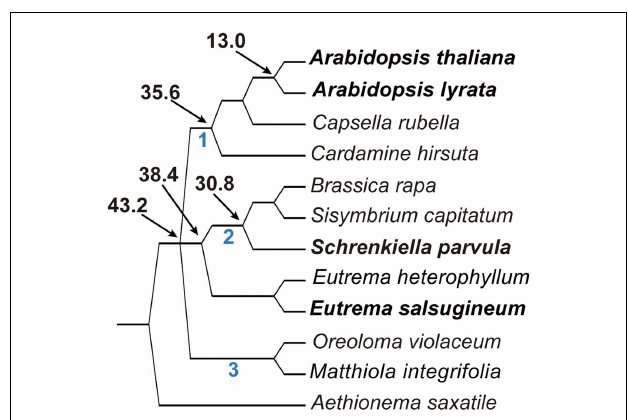
FIGURE 1 |Abbreviated phylogeny of the Brassicaceae inferred from ndhF and PHYA sequence data shows the relationship and divergence times of the four